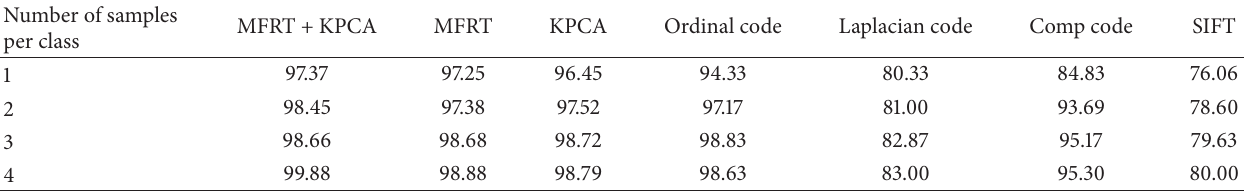
Table 3: Accuracy measures from CASIA right and left hand multispectral palm print